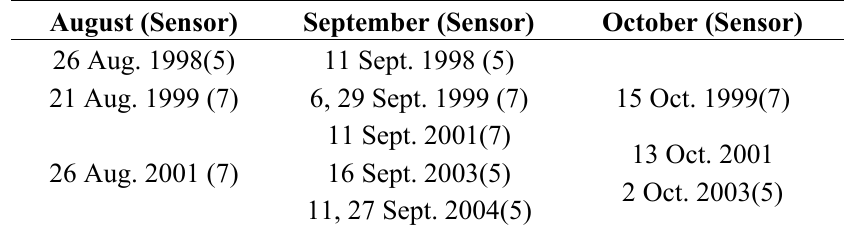
Table 2. Landsat Thematic Mapper images acquired for the five years of analysis.